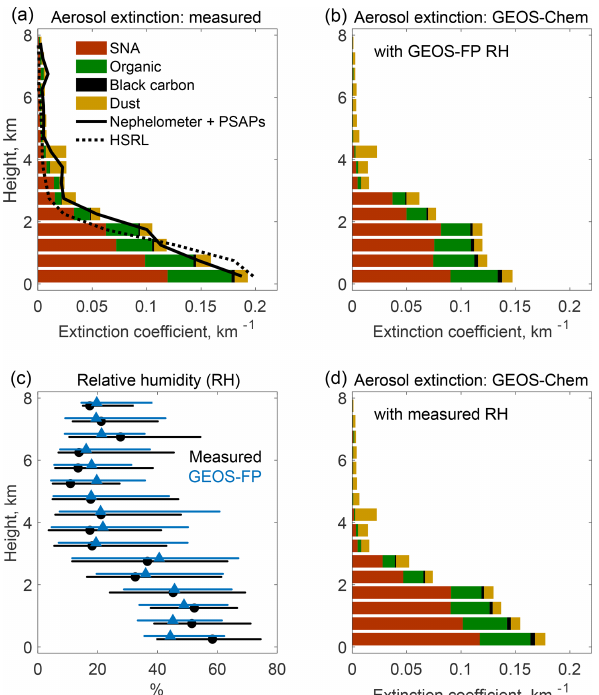
Figure 3. Vertical profiles of aerosol extinction coefficients and relative humidity (RH) during KORUS-AQ. Panel (a) shows the mean observed vertical distributions of 550nm extinction coeffi- cients measured in situ (nephelometer + PSAPs; at ambient RH) and remotely (HSRL), along with an independent calculation (col- ored horizontal bars) from the measured mass concentrations of major aerosol components, measured RH, and GEOS-Chem opti- cal properties as given in Table 3. Panel (b) shows the mean aerosol extinction profile in GEOS-Chem and the contributions from the different model components. Panel (c) is the median vertical profile of RH (horizontal bars are 25th–75th percentiles) from aircraft mea- surements and the GEOS-FP assimilated meteorological data used to drive GEOS-Chem. Panel (d) is the same as (b) but calculated using measured